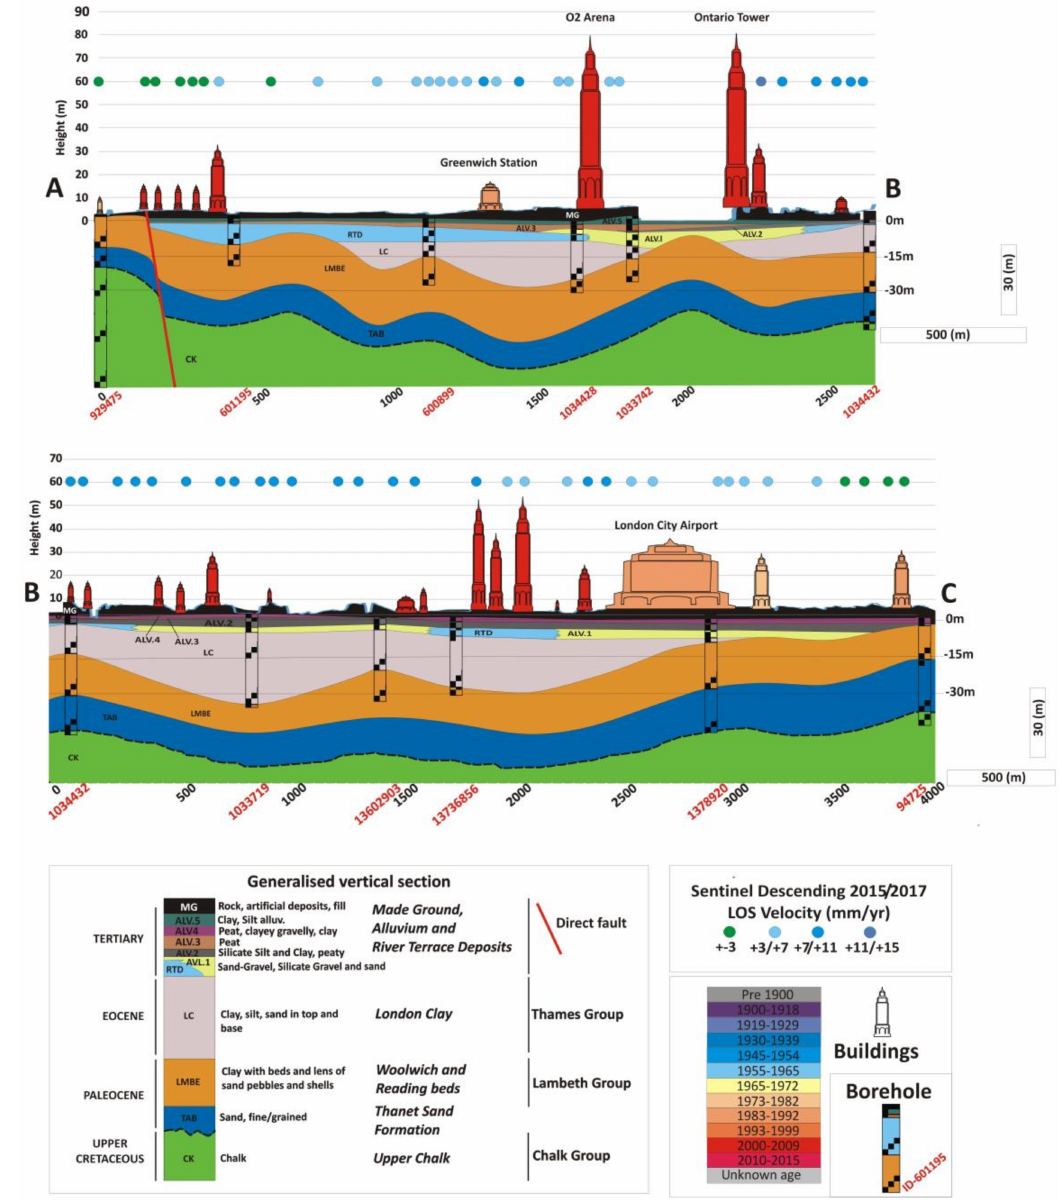
Figure 11. Cross section and buildings age. Based upon Groundhog Desktop data; with the permission of the British Geological Survey. See the location of the cross section in Figures 8 and